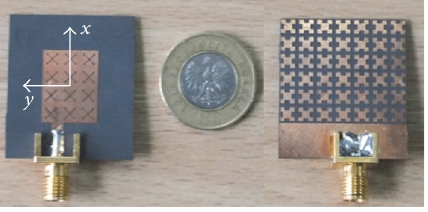
Figure 4: Picture of the fabricated